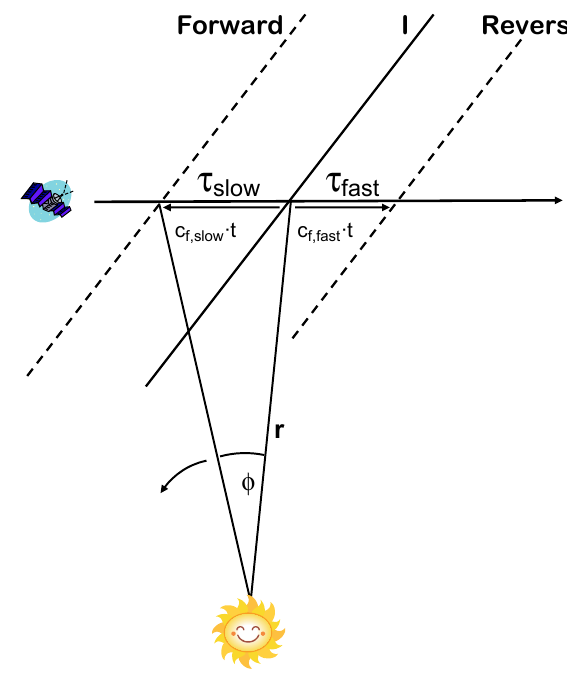
Fig. 5. Simplified schematic diagram for the estimation of time delays between crossings of reverse shocks (pressure waves), inter- face, and forward shocks (pressure